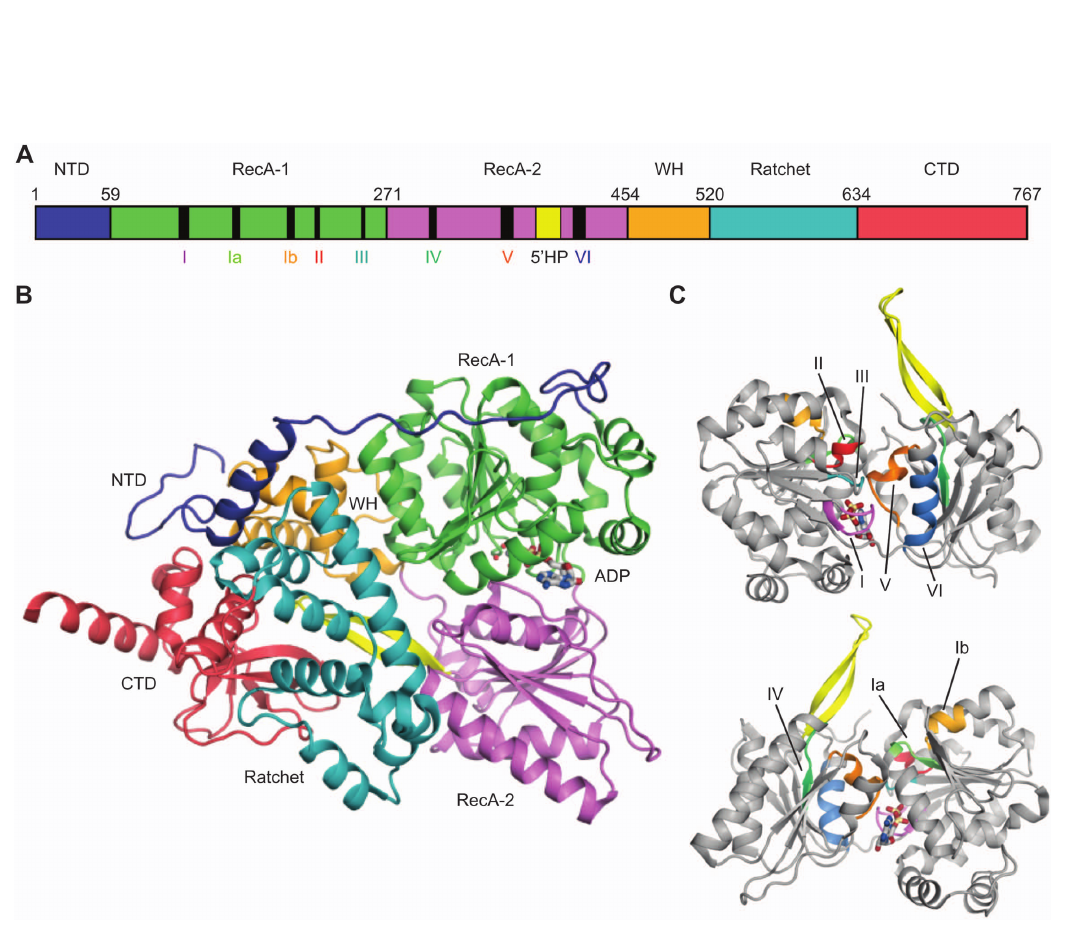
Figure 1 Structure of yeast